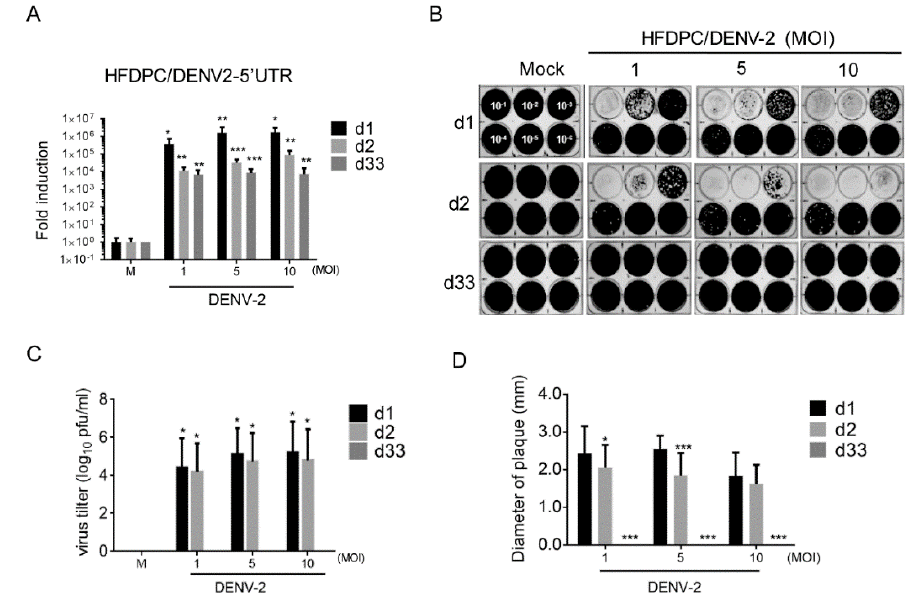
Figure 4. Evaluation of the DENV-2 replication in HFDPCs after prolonged infection. ( A ) The DENV-2 RNA (5 (cid:48) -UTR) replication was detected by qRT-PCR in HFDPCs (4 × 10 4 ) with DENV-2 (MOI 1, 5, and 10) after 1, 2, and 33 days. The expression level of DENV-2 RNA was normalized to Gapdh , and the fold induction to mock control. Data are presented as mean ± SD from three independent tests. ( B ) The plaque assay was conducted with the culture medium of DENV-2-infected HFDPCs (dilution factor: 10 − 1 to 10 − 6 ). ( C ) The virus yield by HFDPCs from the plaque assay are presented in log 10 plaque-forming units per milliliter (PFU / mL) from three independent assays. ( D ) The diameter of the plaque size in the plaque assay. Data are presented as mean ± SD, * p < 0.05, *** p < 0.001, *** p < 0.005 vs. mock control.